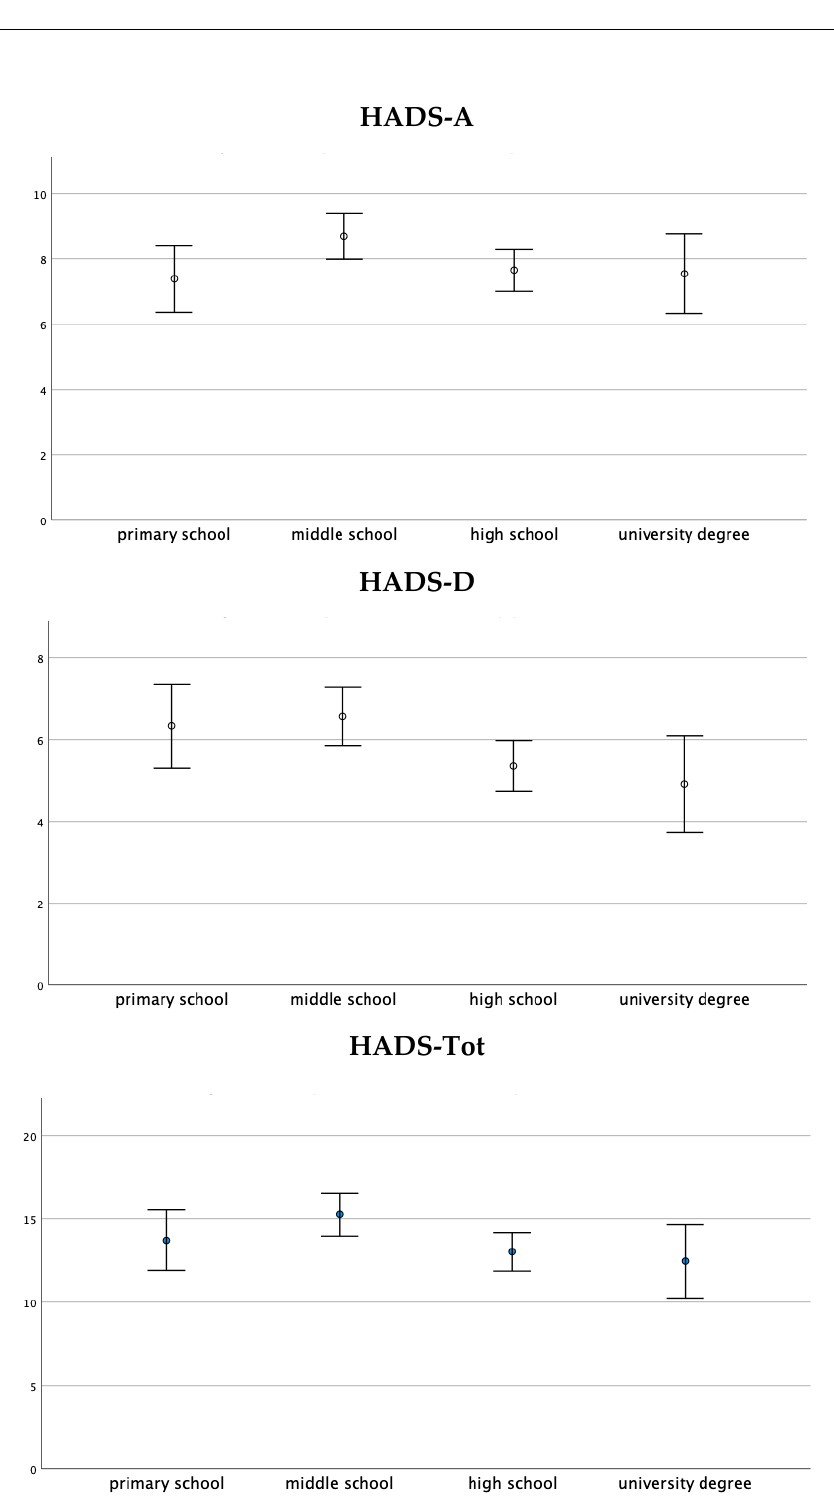
Figure 3. One-way ANOVA on the HADS-A, HADS-D, and HADS-Tot scores with respect to the education level group. Data are presented as the mean ± standard deviation. The HADS-A, HADS-D, and HADS-Tot scores were significantly different between the education level groups (respectively, F(3, 416) = 2.296, p < 0.05; F(3, 416) = 3.277, p < 0.05; and F(3, 416) = 2.832, p < 0.05).